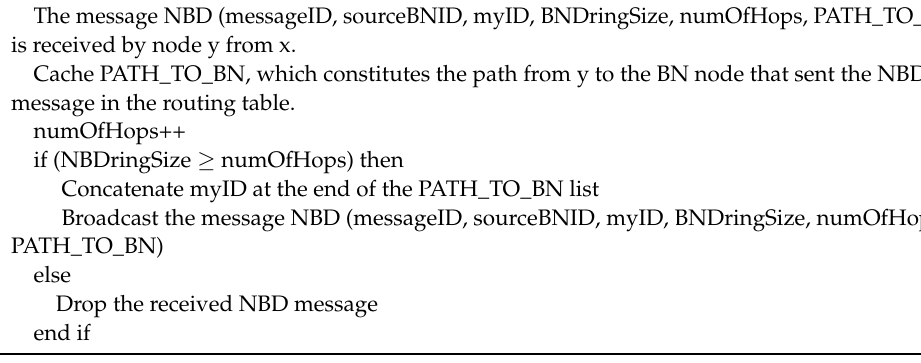
Algorithm 6: NBND at the non-backbone